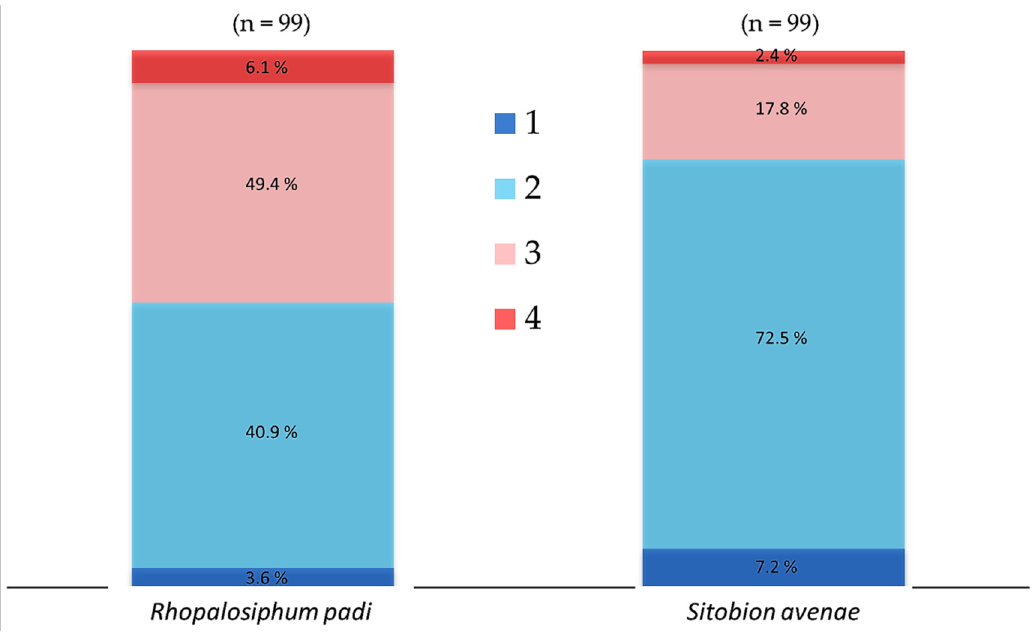
Figure 1. Cumulative percent mortality of cereal aphids Rhopalosiphum padi and Sitobion avenae exposed chronically to 31 ◦ C. For each species, 33 aphid individuals were exposed from each of the laboratory-reared F 1 , F 2 and F 3 generations. Dead aphid individuals were divided into four mortality time periods, i.e., 1–4, representing susceptible-to-tolerant thermal threshold levels. For R. padi , the mortality time periods 1–4 refer to the individuals that died within 6–24, 24–48, 48–72 and 72–96 h, respectively, while for S. avenae , mortality time periods 1–4 refer to the individuals died within 6–18, 18–36, 3–54 and 54–66 h,